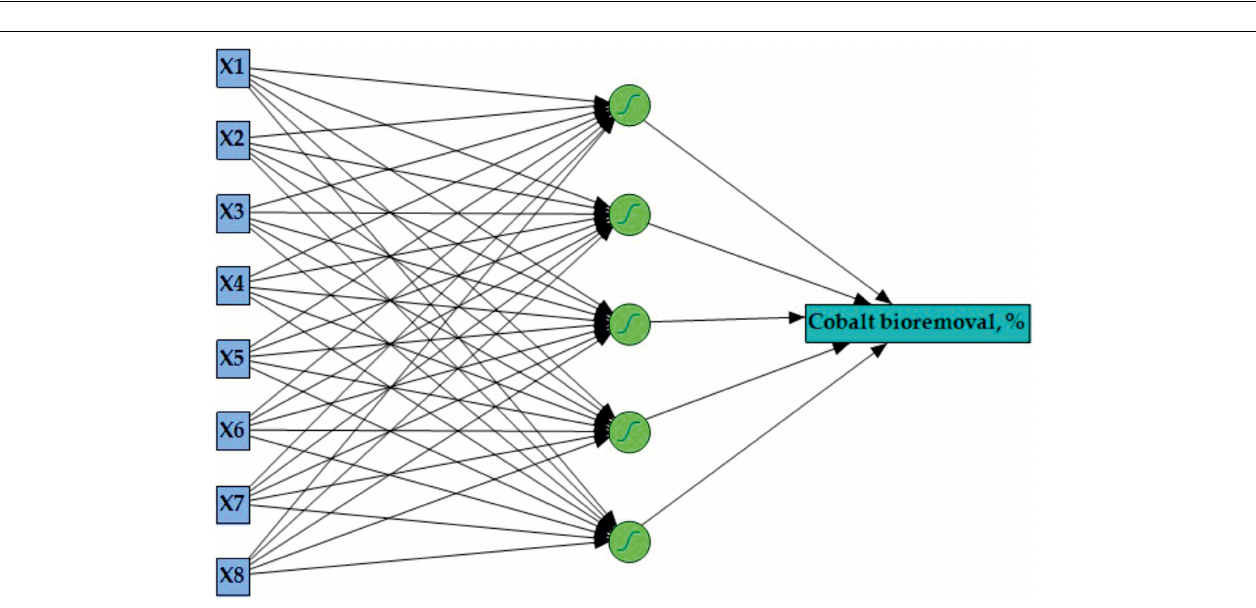
FIGURE 2 | The plots of residual vs. predicted values (A) and the standardized residual vs. raw number (B) of the definitive screening design (DSD) data of Co (II) removal by P. alcaliphila NEWG-2.